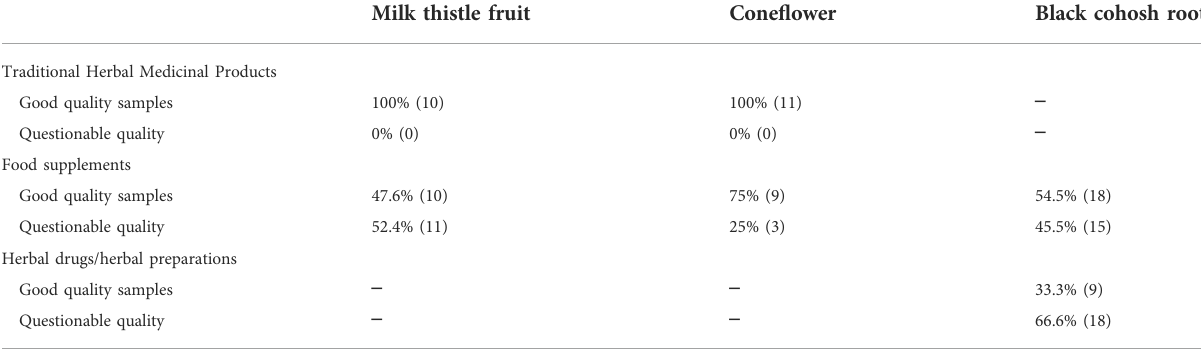
TABLE 5 Classi fi cation of the samples as having good or questionable quality, grouped according to their regulatory status. Percentages are given in relation to the total number of samples of each category and the absolute number of samples in parenthesis. Milk thistle